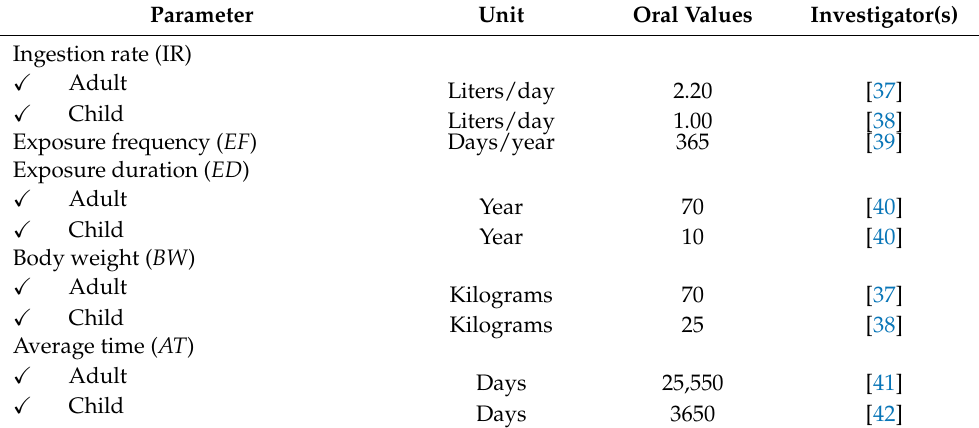
Table 3. Parameters included in the calculation of CDI in